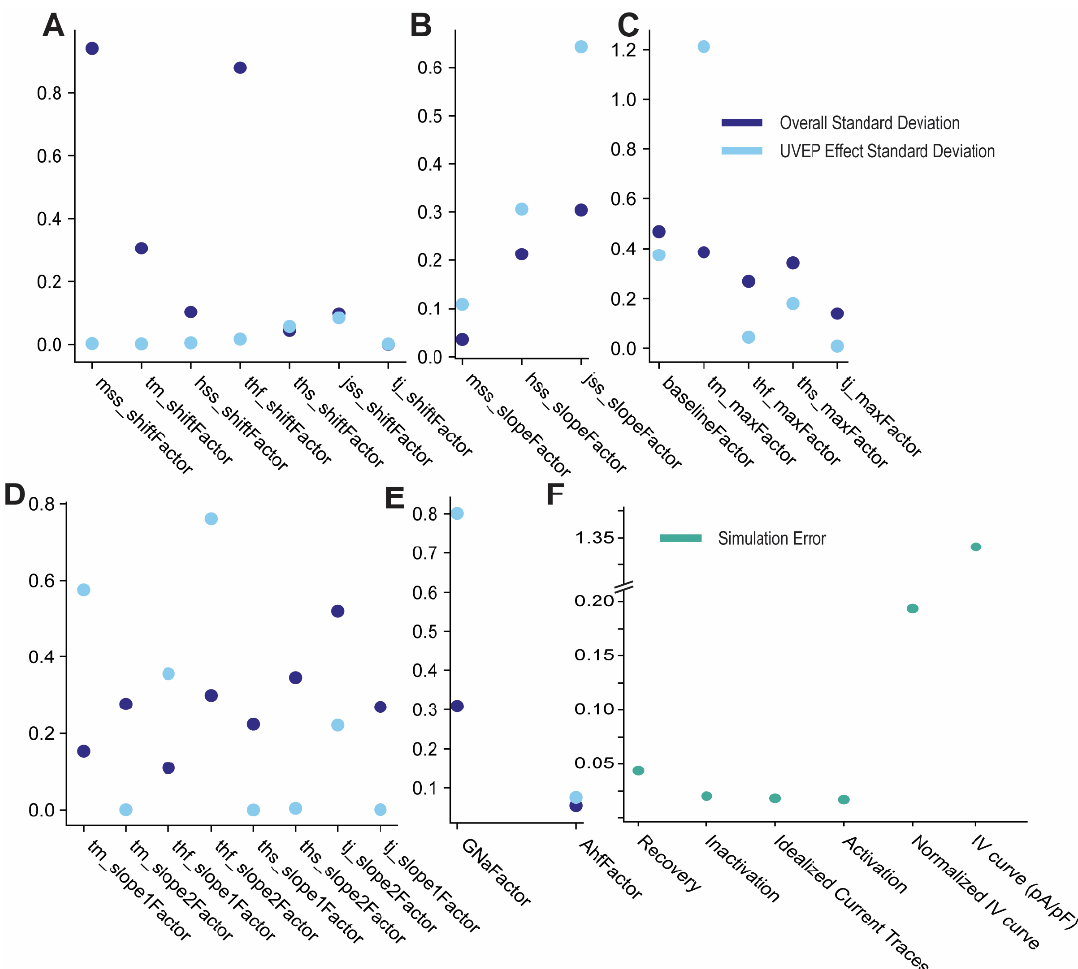
Figure 5. Fitting of model parameters using maximum a posteriori (MAP) estimates. ( A – E ) The overall standard deviations (dark blue) and the UVEP effect standard deviations (light blue) for each model parameter. Estimates for standard deviations were made using maximum a posteriori values that maximize the likelihood of the statistical model (Appendix A). Model parameter factors are grouped according to functionality. ( A ) Parameter factors responsible for locations of steady state and rate curves. ( B ) Parameter factors responsible for the steepness parameters of the steady state curves. ( C ) The minimum and maximum values of the rate constants. Baseline is scaled for each rate constant by constants 1 / 15 , 1 / 10 , 1, 1, for gates m , h f , h s , j respectively. ( D ) The steepness parameters for the rate constants. ( E ) The conductance, G Na , and the proportion of fast to slow inactivation. ( F ) The estimated standard deviations for the error components in the model. Each error term corresponds to a different type of experiment. IV curve simulation error has units pA/pF, while all other errors are for normalized measurements and are